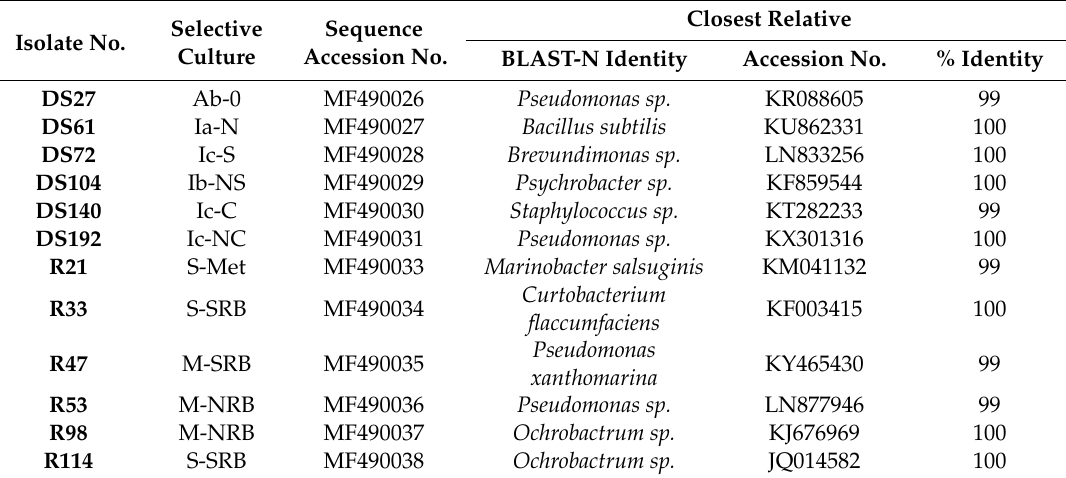
Table 6. BLAST results obtained for the 16S rRNA gene sequence alignments of the 12 biosurfactant-producing isolates. DS indicates isolates from the deep-sea selective cultures and R from the estuarine selective